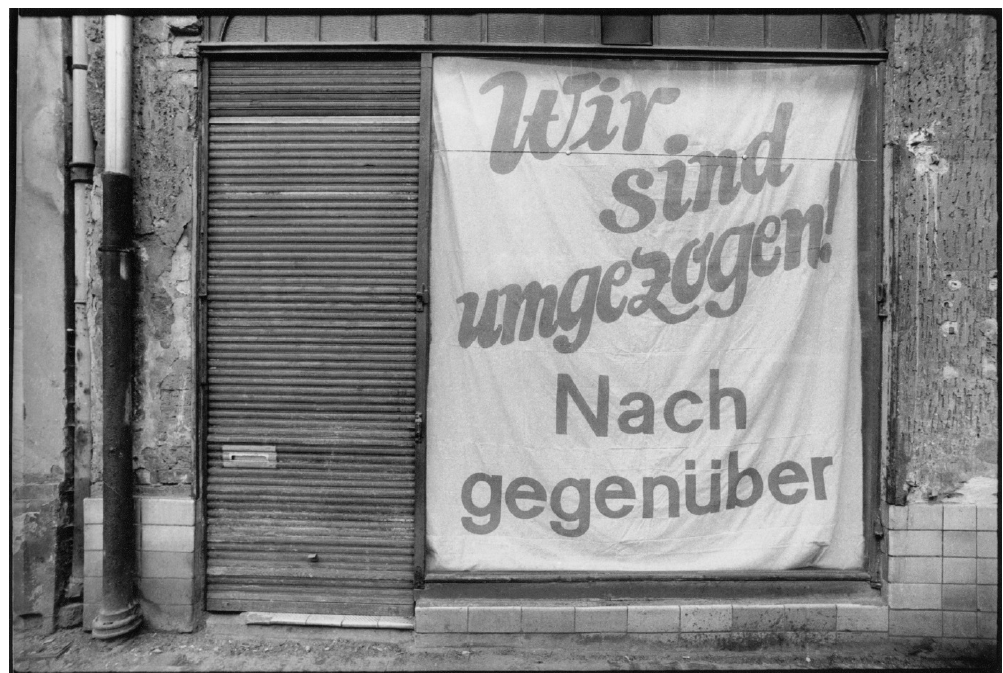
Figure 3. Harald Hauswald, Hans-Otto-Straße, Berlin-Prenzlauer Berg (Hans-Otto-Straße, Berlin-Prenzlauer Berg), 1983. Photo Credits: Ostkreuz–Agentur der Fotografen/Harald Hauswald.